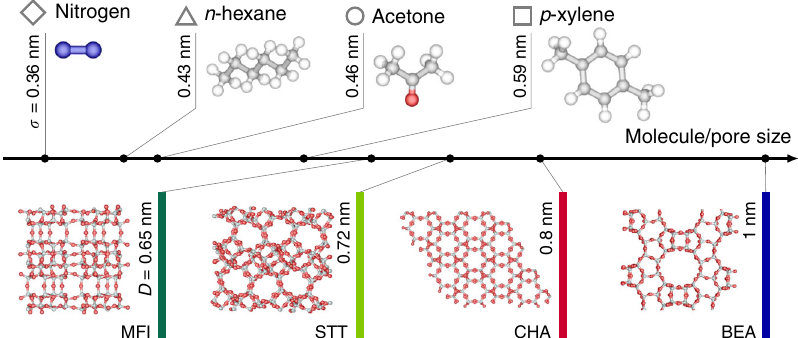
Fig. 2 Fluids and nanoporous materials. Different fl uids and zeolite matrices considered in this paper sorted according to their size ( σ for the fl uid molecule and D for the zeolite pore). Throughout the paper, solvents (upper part) are denoted according to the following symbol code: N 2 (lozenges), n -hexane (triangles), acetone (circles), and p -xylene (squares). For each fl uid, the molecular size σ was taken as the kinetic diameter which is estimated to match the second virial coef fi cient. This choice is particularly suitable as it applies both to fl uids in gas-like and liquid-like states. The zeolite matrices (lower part) are denoted according to the following color code: silicalite-1 (MFI, dark green), STT (light green), chabazite (CHA, red), and beta (BEA blue). For each zeolite, the pore size was estimated from the fractional free volume as determined using the Connolly surface area method (Supplementary Fig.